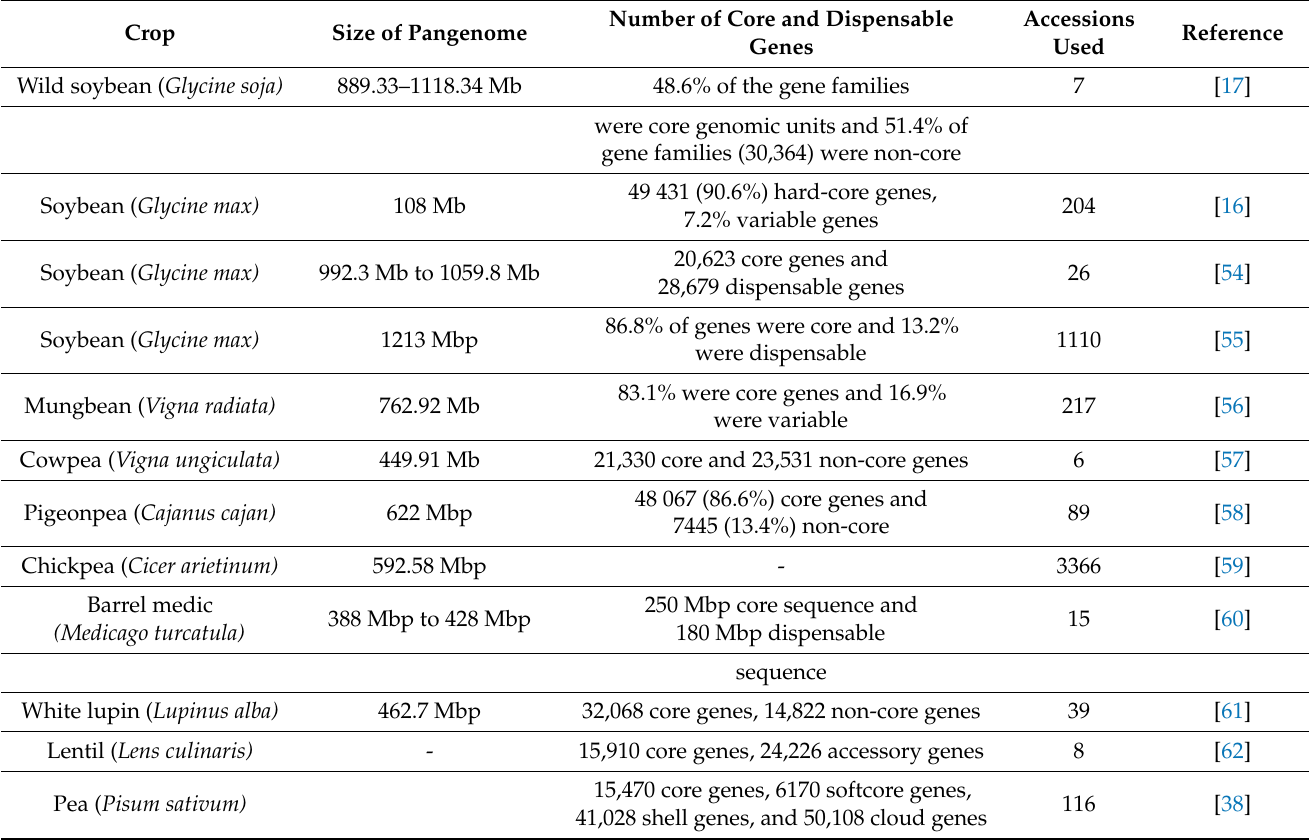
Figure 2. Legume pangenomes and key learnings for crop improvement. Table 1. List of various pangenomes constructed in various legume